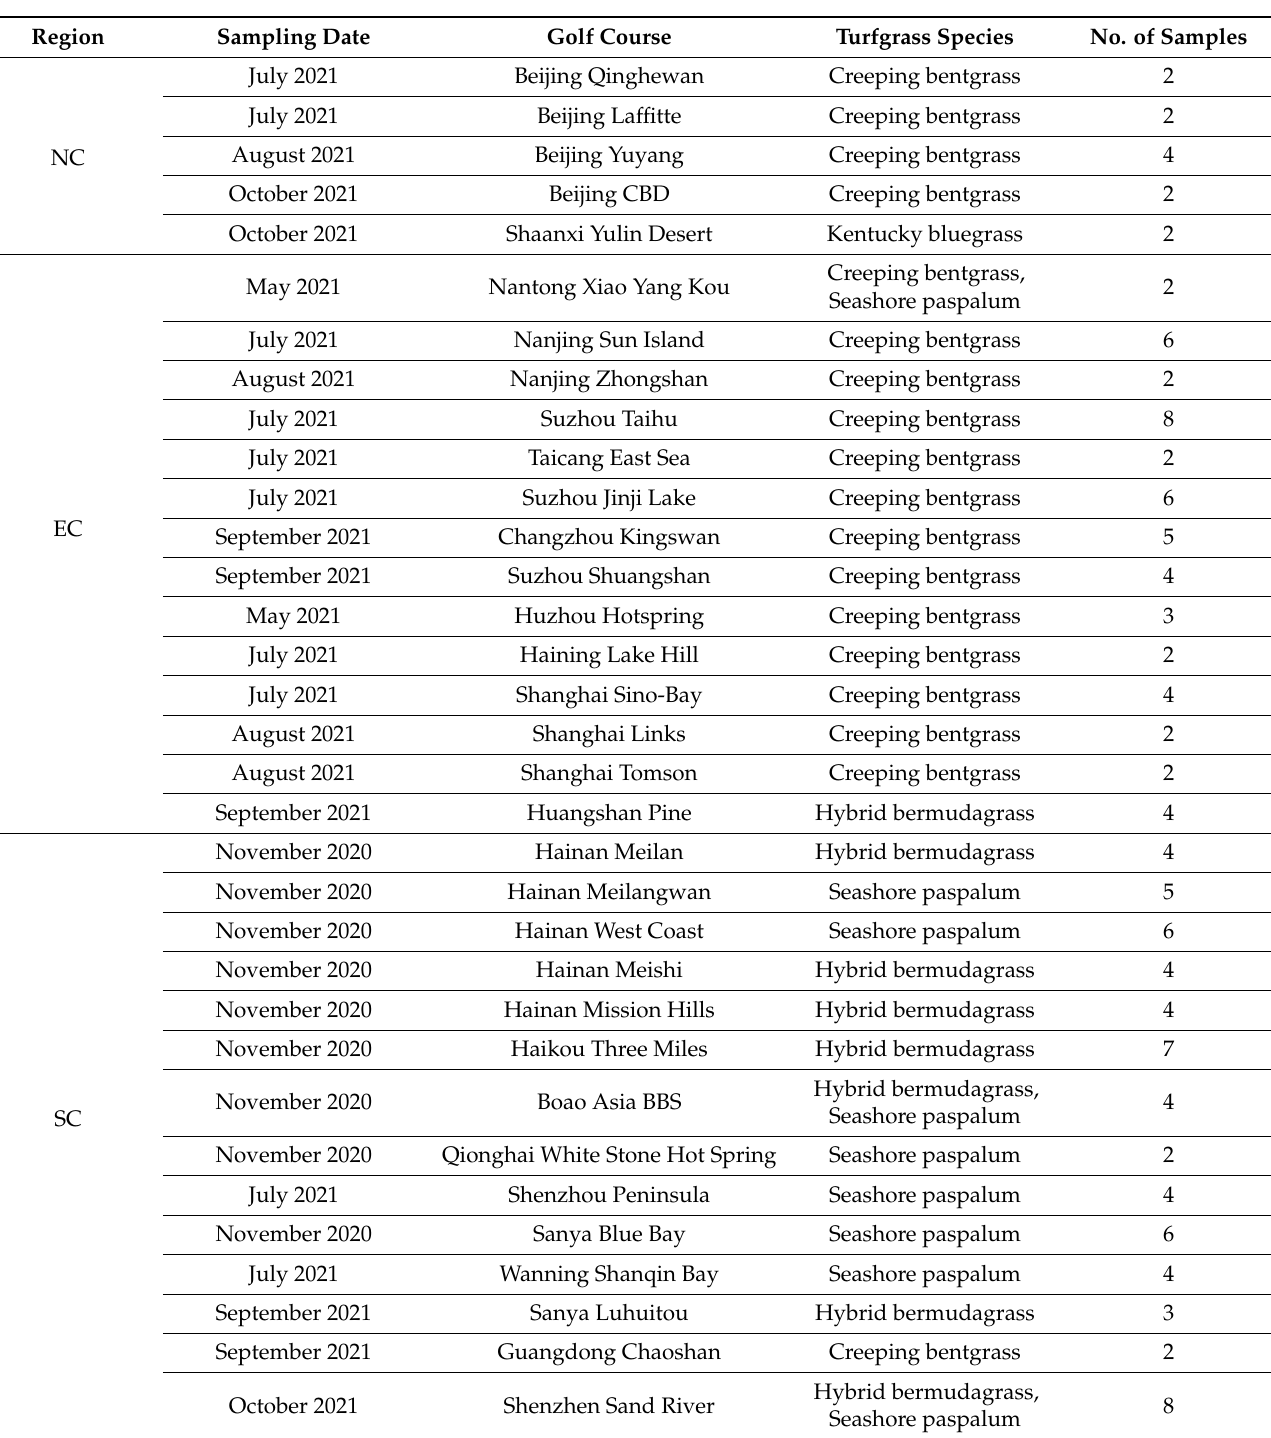
Table 1. Detailed information on turfgrass soil samples collected from different regions of